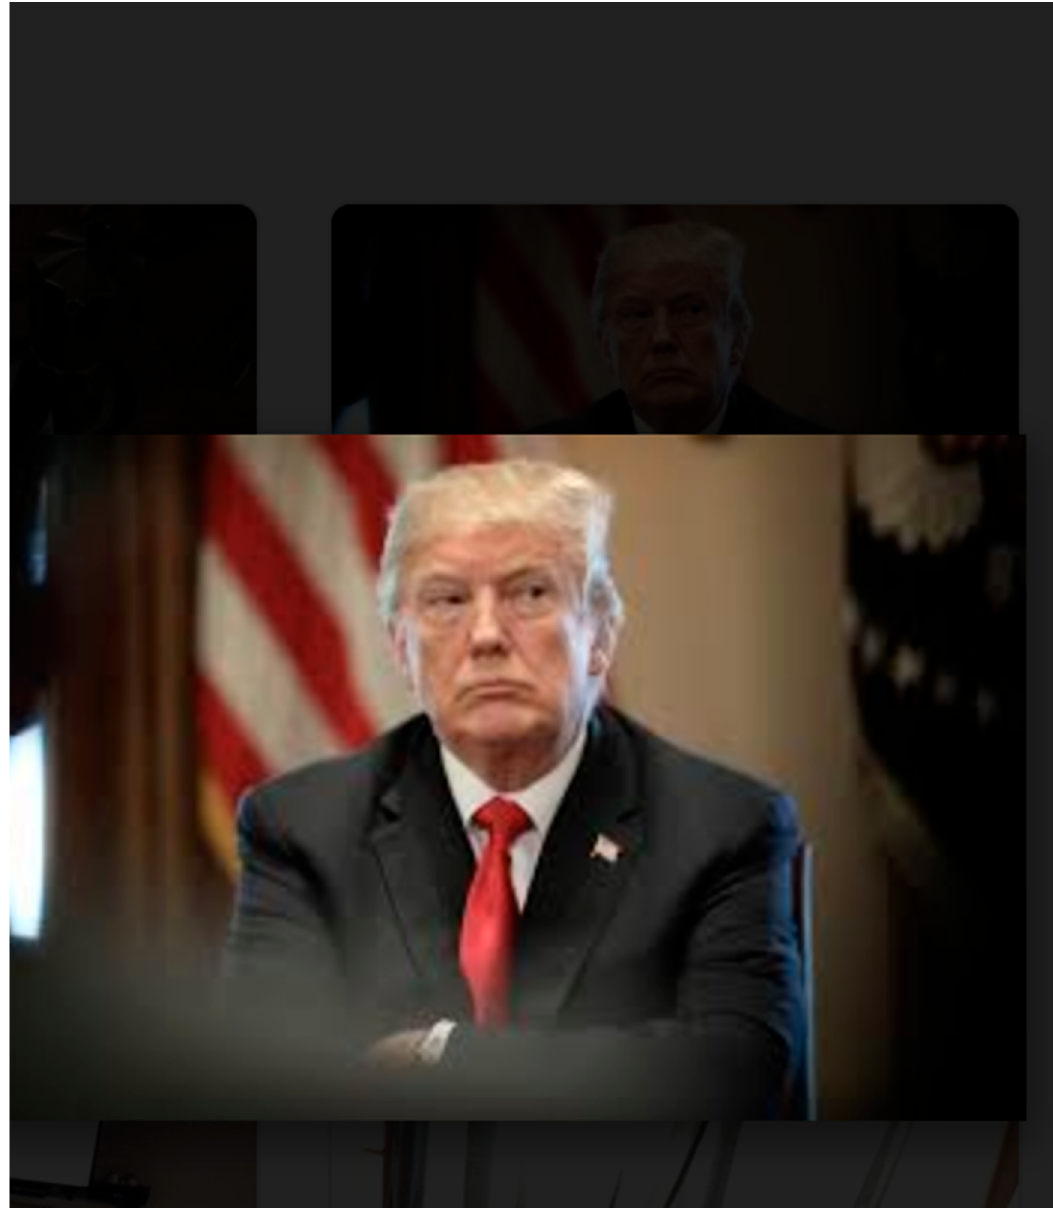
Figure 2. Reflecting the politics of the time, an RRB living in Milwaukee, who is also a Holocaust survivor, submitted the above photo to illustrate the worst thing about living in the U.S. According to her, “I’m just glad […] [he wasn’t in charge back then] or we would not be allowed